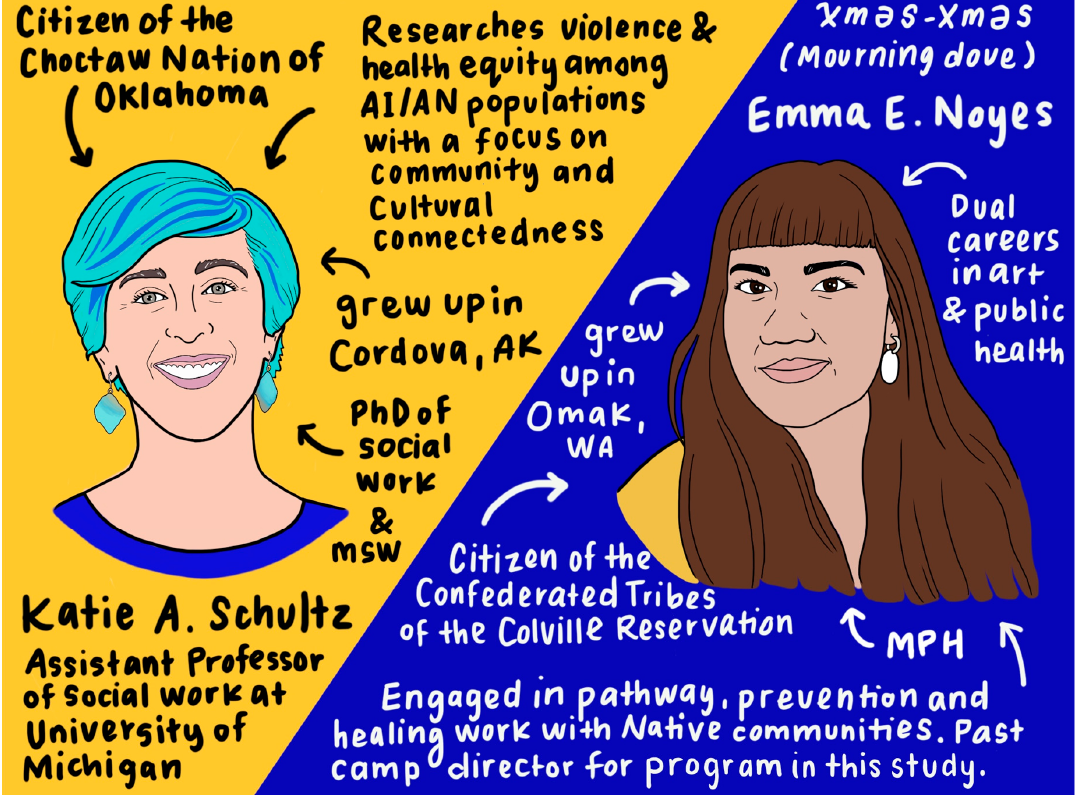
Figure 4. The authors’ portraits are surrounded by information about who they are and where they are from. See I.D. 4 in Appendix A.